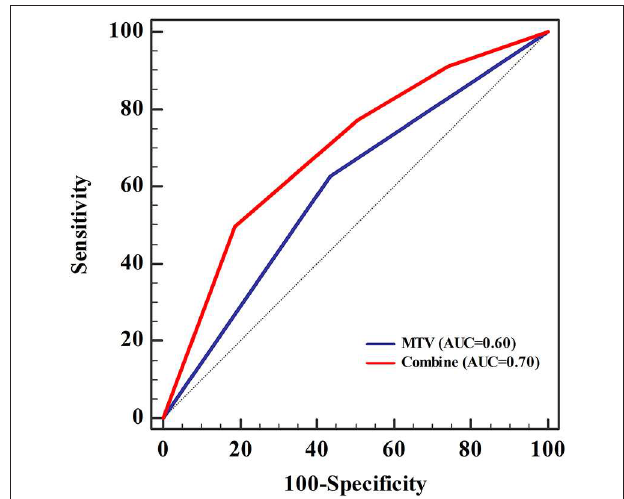
FIGURE 2 | The area under the receiver operating characteristic curve (AUC) for metabolic tumor volume (MTV) was 0.60, which increased to 0.70 when clinical data (smoking status) was combined. Sensitivity and specificity were 0.50 and 0.81, respectively. The cut-off value of MTV was 11.55, and was 0.56 when combined with the clinical data (smoking